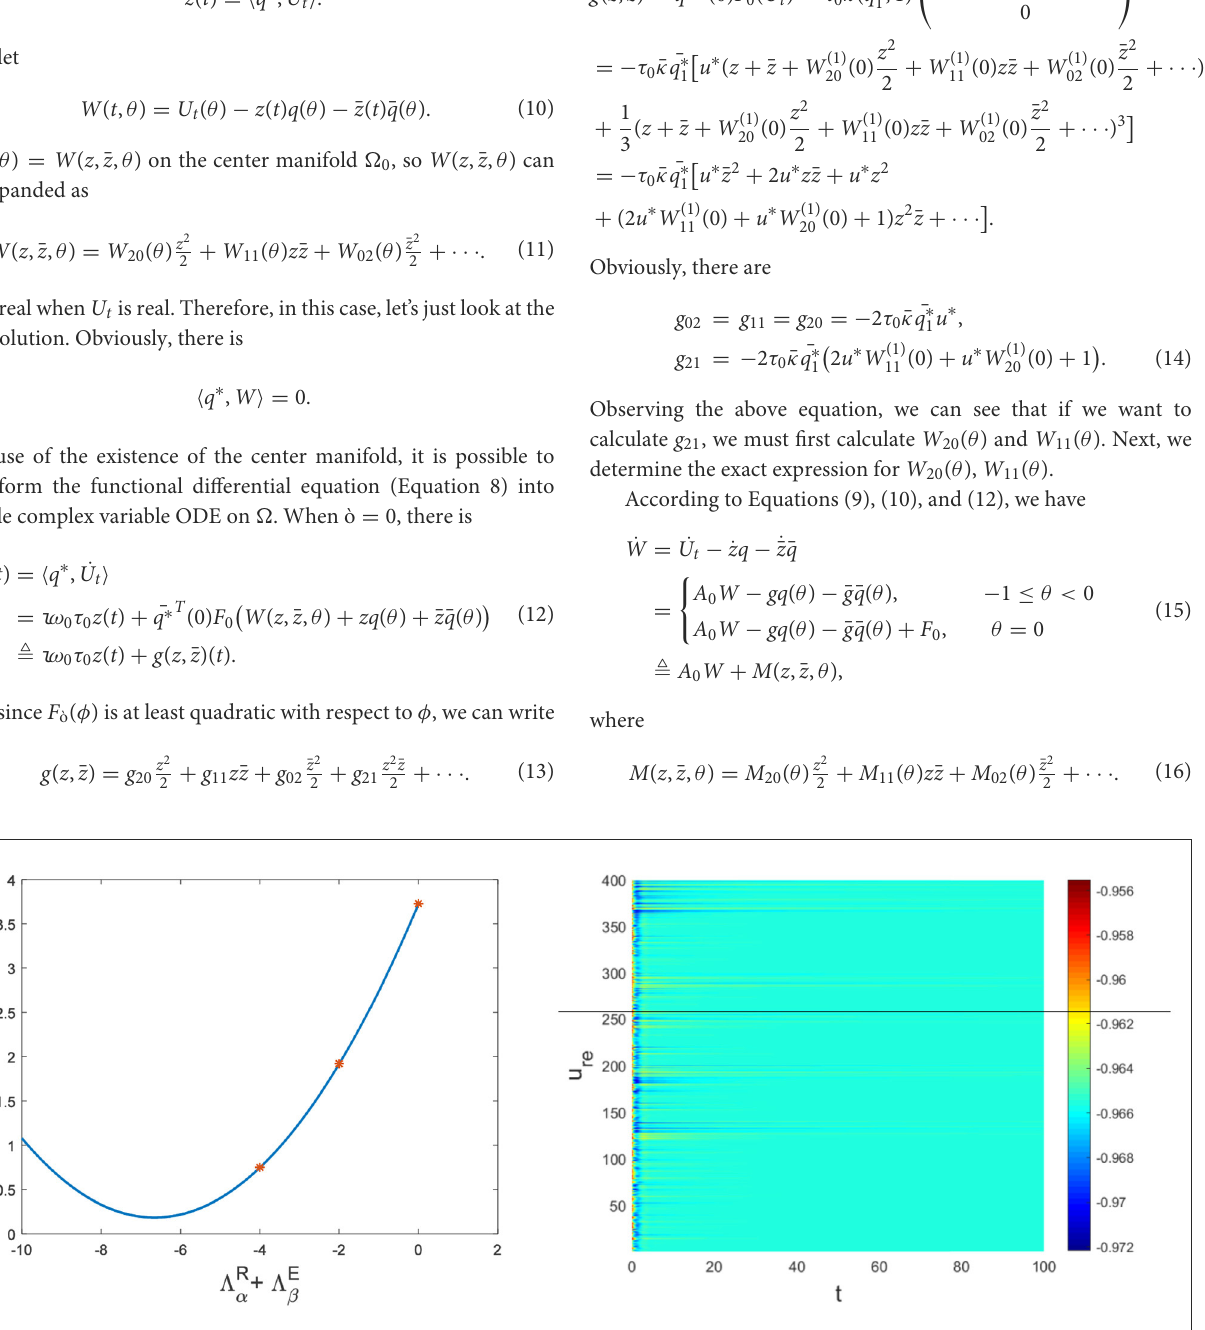
1, b 1, c 2, d 1, I 0.7, D u 0.01, D v 8, p 0.01. The = = = = = = = =